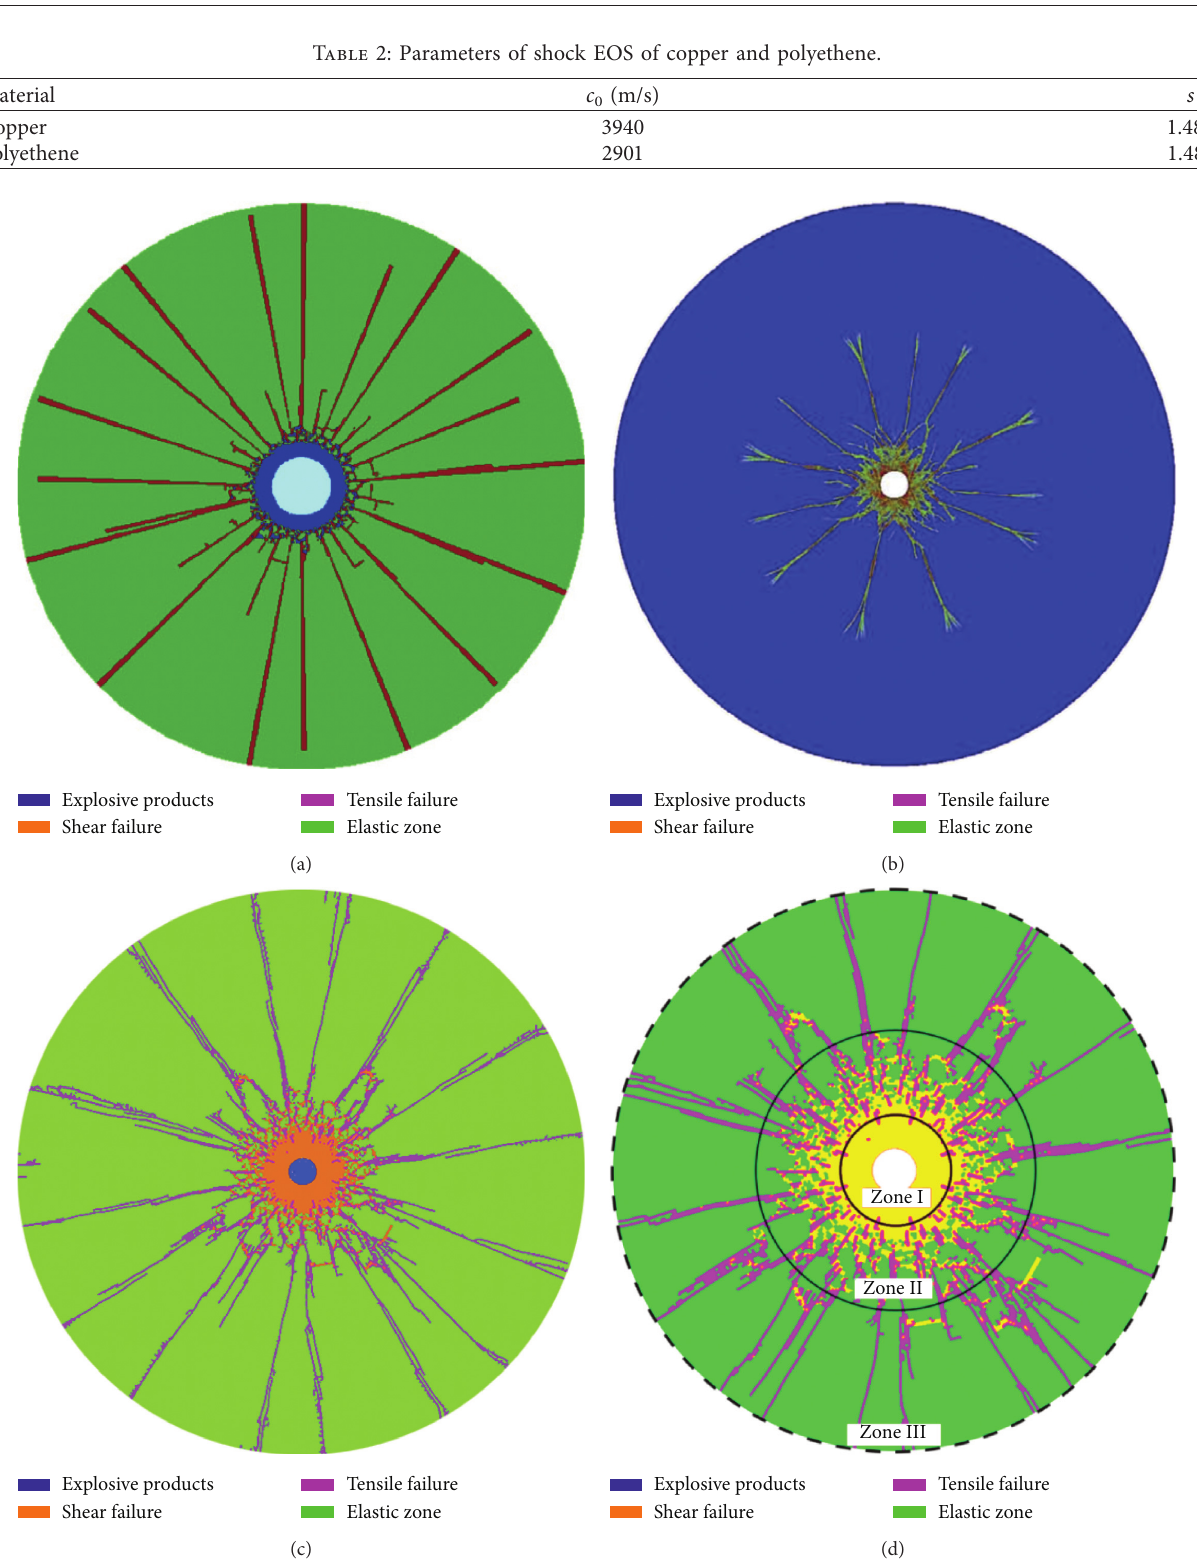
Figure 5: Comparison of blast-induced fractures. (a) Numerical result by Zhu et al. [40]. (b) Numerical result by Xie et al. [19]. (c) Numerical result in this study. (d) Damage details near the